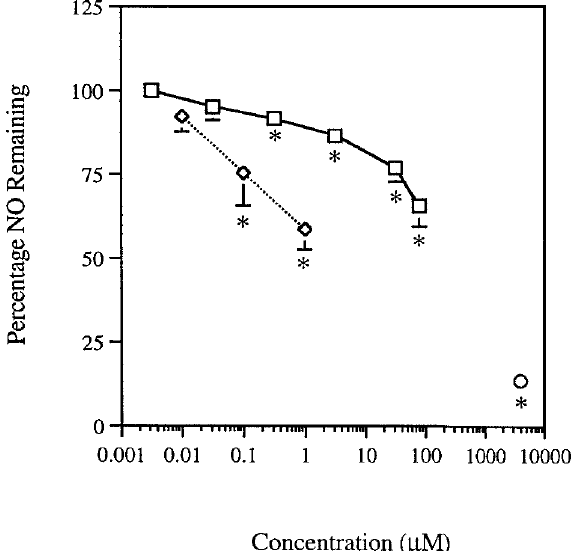
FIG. 2. Effect of Ac2–26 and dexamethasone on basal NO release by rat AM in vitro . Percentage NO remaining following L-NMMA, peptide or dexamethasone treatment was calculated using the following formula: (NO release by unstimulated AM + peptide/NO release by unstimulated AM) 3 100 Data are presented as mean ± SEM, n = 6, * P < 0.05, Wilcoxon’s signed rank test for paired data; open squares represent NO release in the presence of Ac2–26; open diamonds represent NO release in the presence of dex- amethasone; open Circle represents NO release in the presence of L-NMMA.